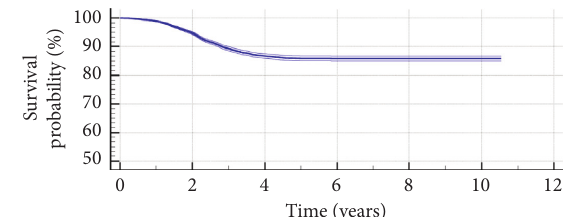
Figure 2: Kaplan–Meier survival curve with its confidence interval concerning transparent posterior capsule survival after cataract surgery (log-rank test: p < 0 . 01) for the sample of eyes evaluated. Mean survival time was 9.38 years for the complete follow-up, and mean survival rate was 85.9%.